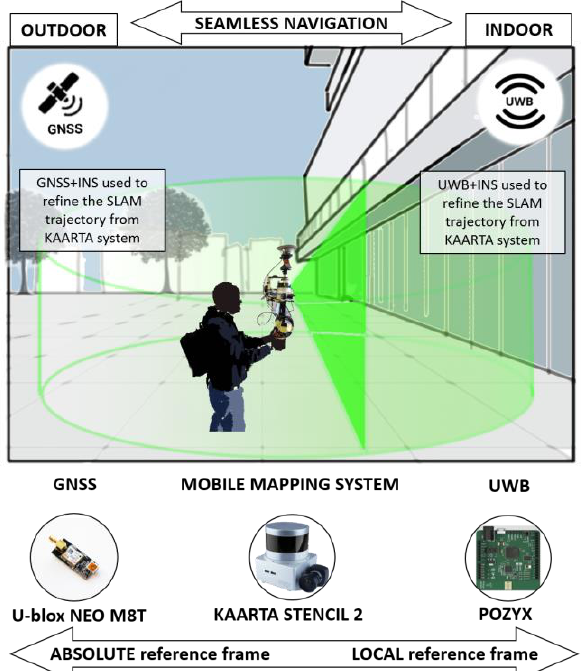
Figure 2. Framework of seamless navigation. GNSS outdoor and UWB indoor are fused with the data acquired by the MMS during the pedestrian